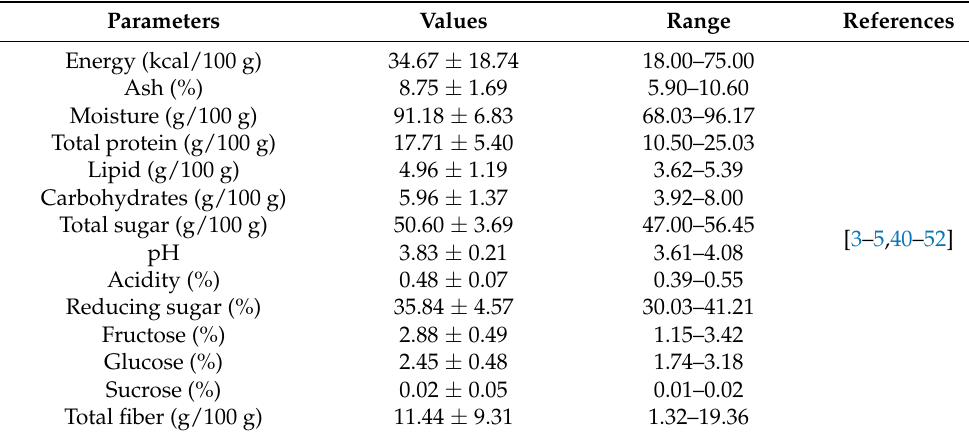
Table 1. Proximate composition of